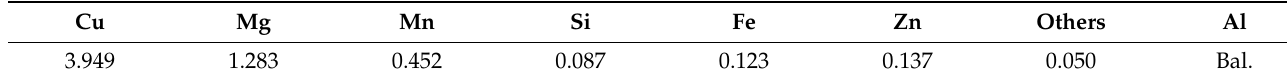
Table 1. Chemical composition of the 2024Al alloy (mass fraction, %).